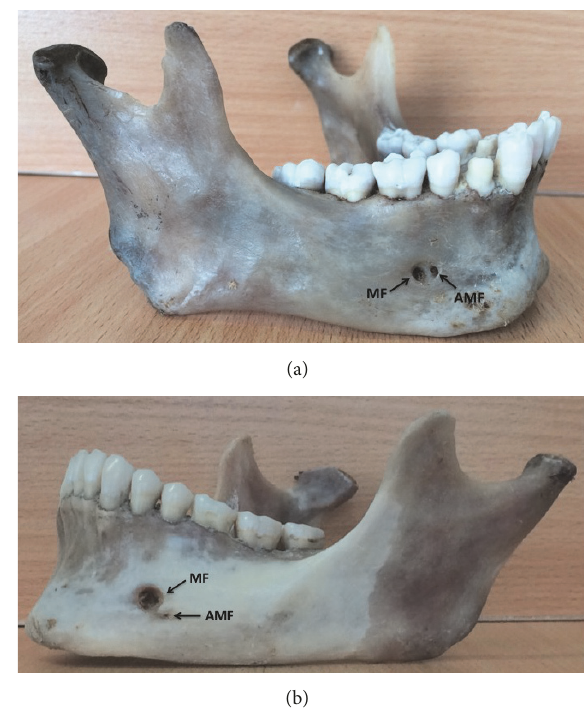
Figure 3: Adult Zambian human mandibles found with MF and AMF. (a) Mandibles found with MF and AMF on the right side. (b) Mandibles found with MF and AMF on the left side.